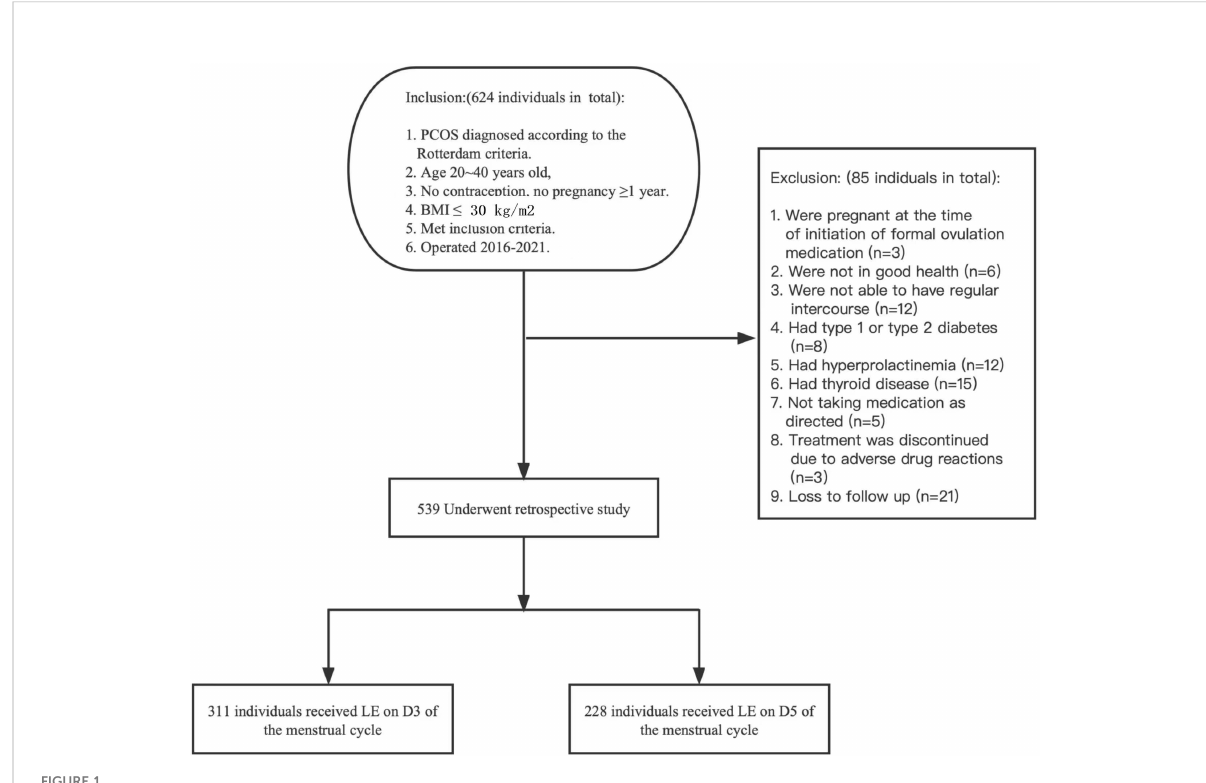
FIGURE 1 Flow Chart Depicting the Patient